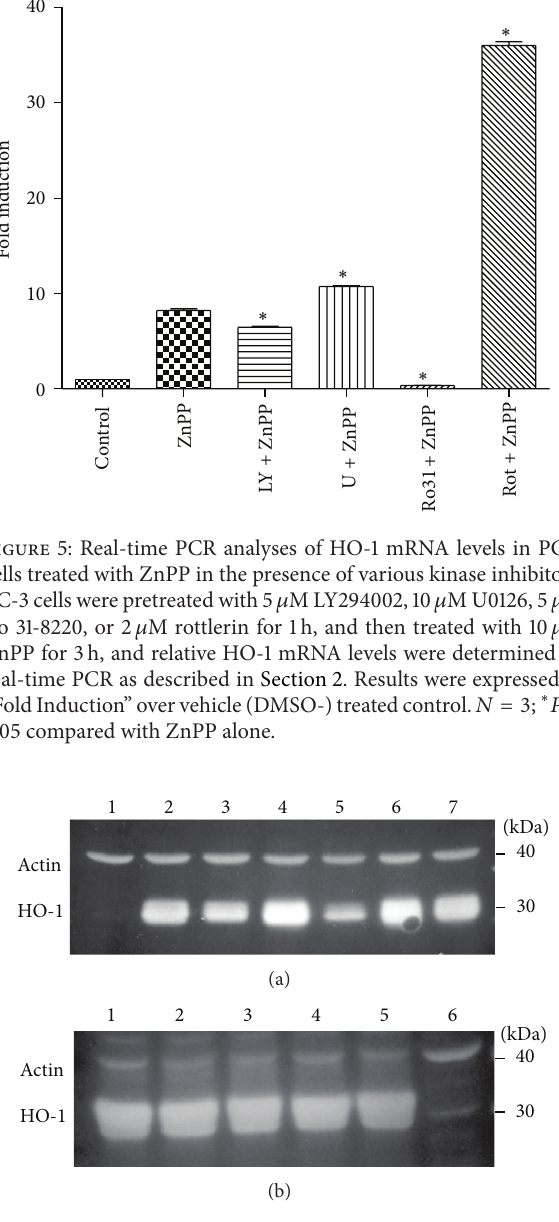
Figure 6: Western blot analysis of HO-1 protein induced by ZnPP in PC-3 in the presence of various kinase inhibitors or antioxidant. (a) PC-3 cells were pretreated with nothing (lane 2), 5 𝜇 M LY294002 (lane 3), 10 𝜇 M U0126 (lane 4), 5 𝜇 M Ro 31-8220 (lane 5), 2 𝜇 M rottlerin (lane 6), or 5 𝜇 M Ro 32-0432 (lane 7) for 2h, and then treated with 10 𝜇 M ZnPP for 24 h. Control cells were treated with equal amount of DMSO for 24 h (lane 1). Total proteins (50 𝜇 g) were analyzed by western blot as described in Section 2, using specific antibodies against 𝛽 -actin and HO-1. Immunoreactive protein bands detected by WesternDot 625 appeared as fluorescent bands. (b) PC-3 cells were pretreated with 5 𝜇 M myristoylated PKC- 𝜃 pseudosubstrate (lane 1), 5 𝜇 M myristoylated PKC- 𝜁 pseudosub- strate (lane 2), 5 𝜇 M myristoylated PKC- 𝜂 pseudosubstrate (lane 3), 5 𝜇 M PKC- 𝛽 inhibitor (lane 4), or nothing (lane 5) for 2h, and then treated with 10 𝜇 M ZnPP for 24 h. Control cells were treated with equal amount of DMSO for 24h (lane 6). Western blot analysis was done as described above.